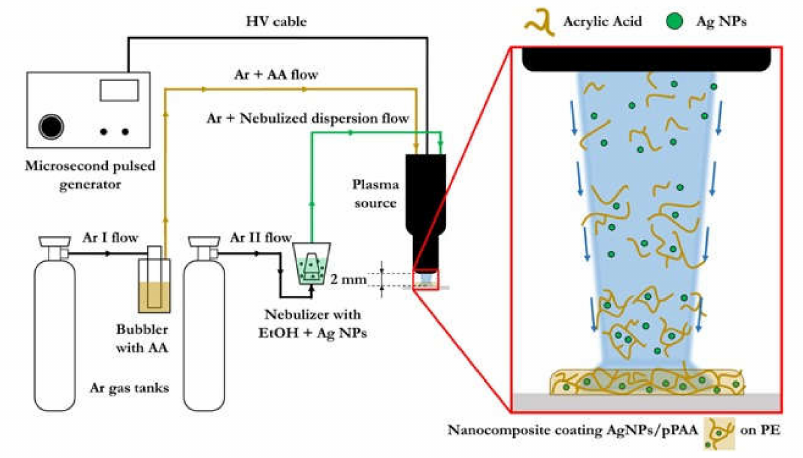
Figure 13. Experimental setup of the plasma co-deposition process of Ag NPs containing organic coatings. Reprinted with permission from [62]. Copyright 2006 John Wiley & Sons,